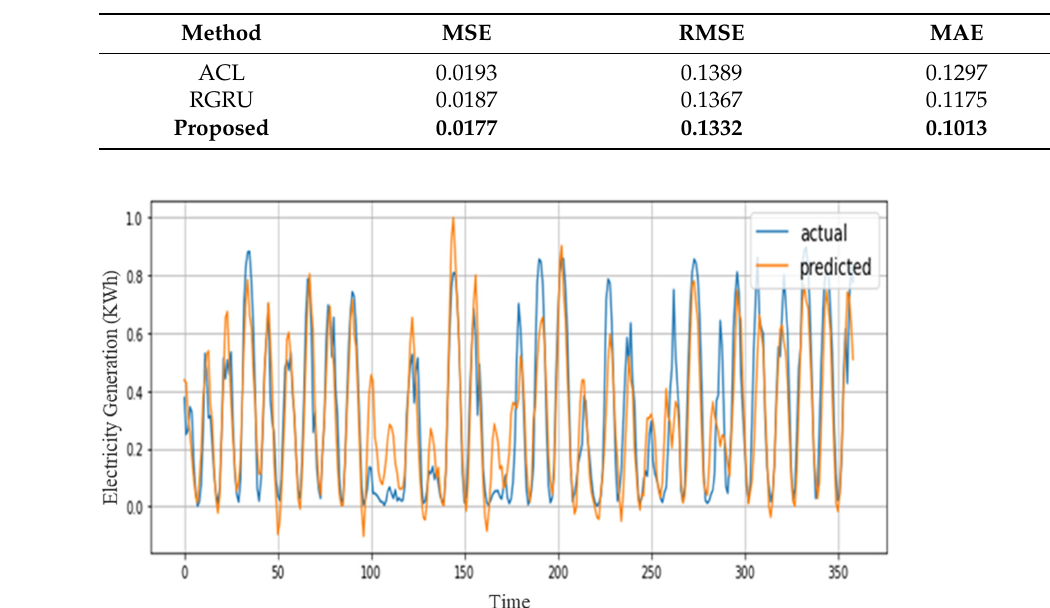
Figure 9. Performance of the proposed model over the solar